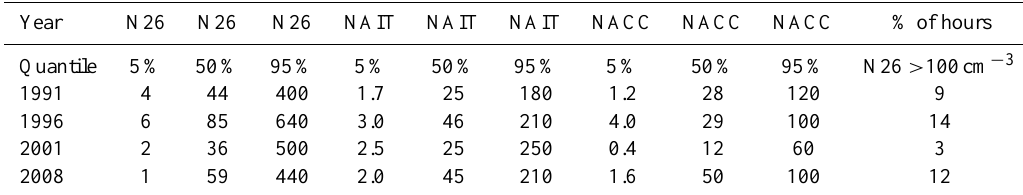
Table 3. As Table 2 but for ultrafine particles (N26,cm − 3 ), for particles larger than 26nm and smaller than the calculated Hoppel-diameter DHO (NAIT,cm − 3 ), and particles larger than DHO and smaller than 600nm (NACC,cm − 3 ). Additionally, the fraction of time with N26 > 100cm − 3 is given.